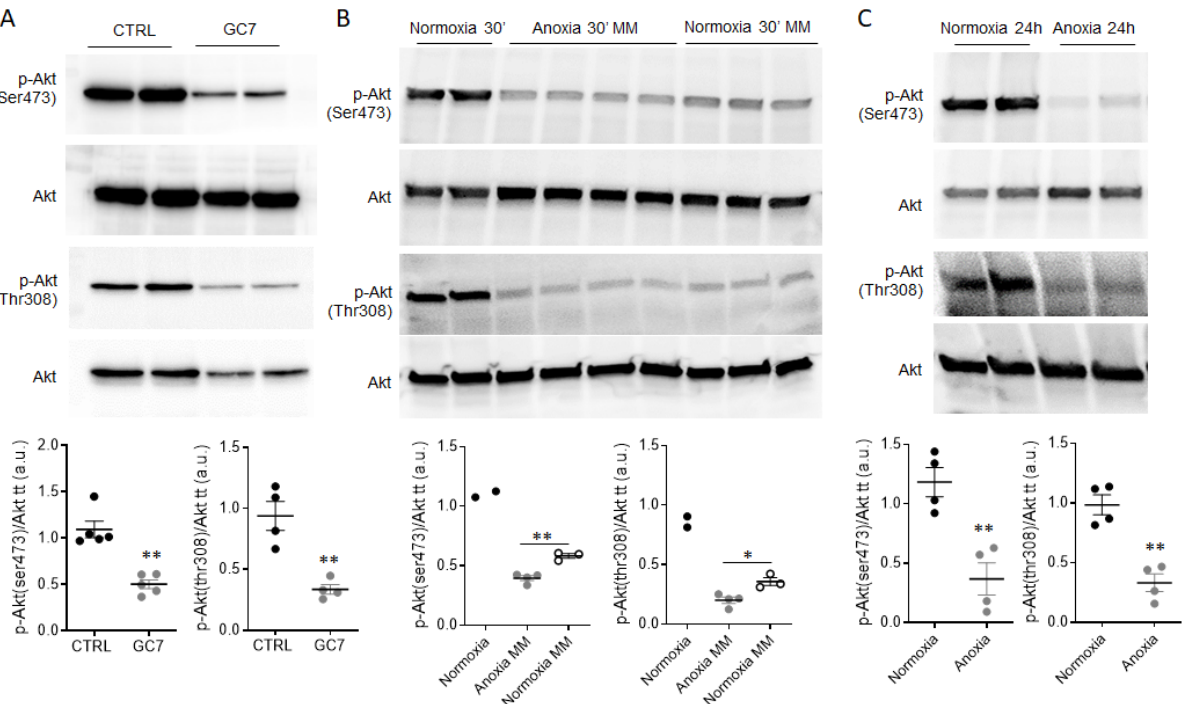
Figure 1. Akt phosphorylation is inhibited by anoxia and by ischemic protective treatment in kidney cells. PCT cells were ( A ) treated for 24 h with 30 µM GC7, ( B ) deprived of nutrients in minimum media (MM) under normoxic or anoxic conditions for 30 min or ( C ) submitted to anoxia for 24 h. At the end of treatment, phosphorylation of Akt on both Ser(473) and Thr(308) sites were assessed by western blot as well as total Akt. The scatter plot of the above Western blot bands quantification represents individual p-Akt/total-Akt ratios along with mean ± SEM. n = 2 to 5. * p < 0.05; ** p < 0.01. Using the same concentrations, confluent PCT cells were pretreated with Akt